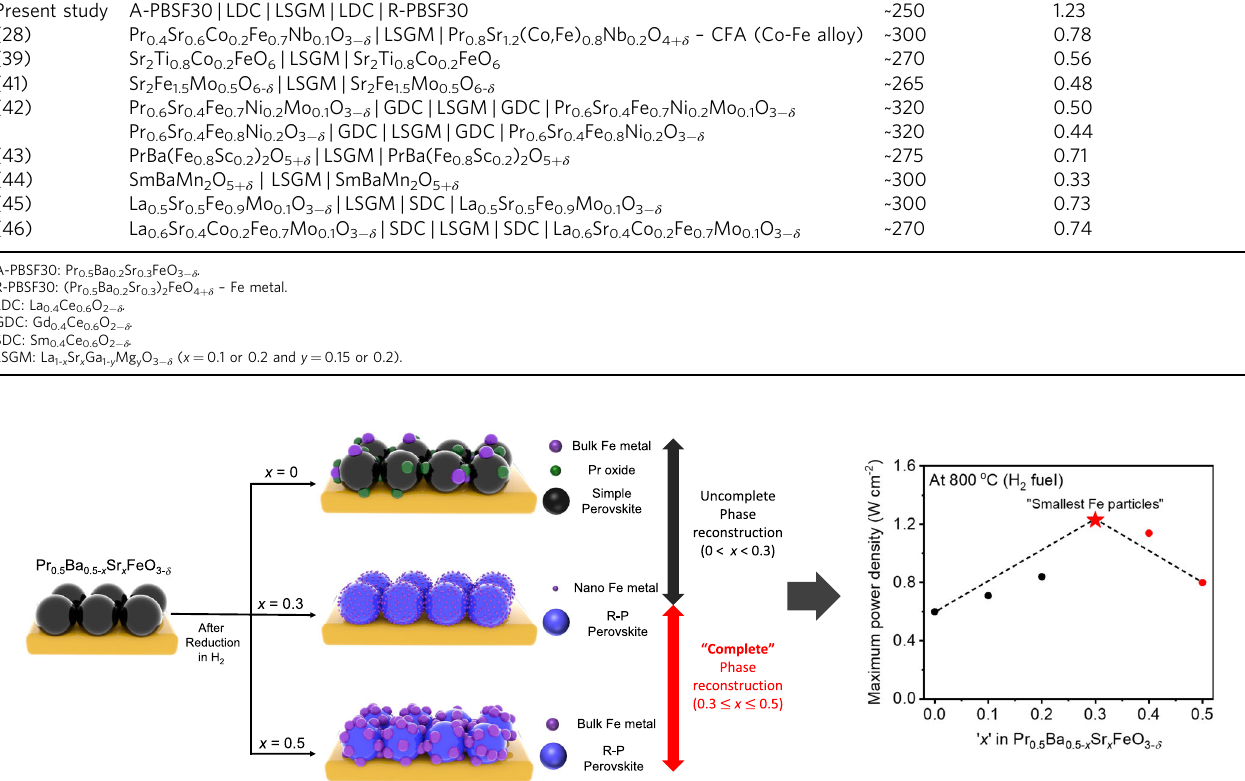
Fig. 6 Schematic illustration of this work. Schematic illustration of the fuel electrode side of Pr 0.5 Ba 0.5 − x Sr x FeO 3 − δ ( x = 0, 0.3, and 0.5) symmetrical cells and its relation to electrochemical U eff = 4.0eV for Mn 3d orbital, U eff = 7.0eV for Ni 3d orbital, and U eff = 6.0eV for Pr 4f orbital 18,56,57 . For the Brillouin zones of the formation energy calculation of cubic perovskite (2×2×4 super cell) and n = 1 R-P perovskite (2×2×1 super cell), 3×3×1 and 3×3×2 Monkhorst-Pack k-point sampling were used, respectively 58 . For the oxygen vacancy formation energy calculations of BO 2 layer between two AO layers, PrO-terminated (001) slab model (2×2 surface, 8 layers with 2 fi xed bottom layers, vacuum layer of 16Å) were used. For the co-segregation energy calculations, FeO 2 - p p terminated (001) slab model (2 2×2 2 surface, 8 layers with 3 fi xed bottom layers, vacuum layer of 16Å) were used. For the Brillouin zones of the oxygen vacancy formation energy and the co-segregation energy calculations, 3×3×1 and 1×1×1 Monkhorst-Pack k-point sampling were used. The optimized lattice parameters of four materials, A-PBSF00 (Ba:Sr = 16:0), Pr 0.5 Ba 0.1875 Sr 0.3125 FeO 3 − δ (Ba:Sr = 6:10), most stable con fi gurations among the total 5 different Ba con fi gurations were used. The relative energies required for the phase reconstruction from simple perovskite to n = 1 R-P perovskite (E recon ) of six model structures with different Sr 2 + concentration were calculated using the total energy difference between